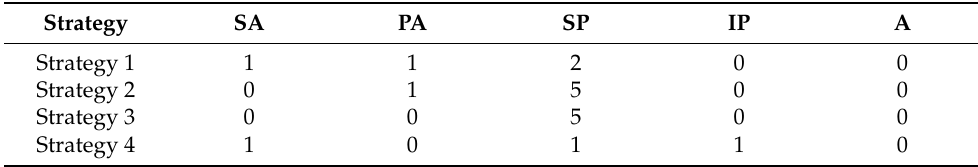
Table 3. Number of new hires needed by